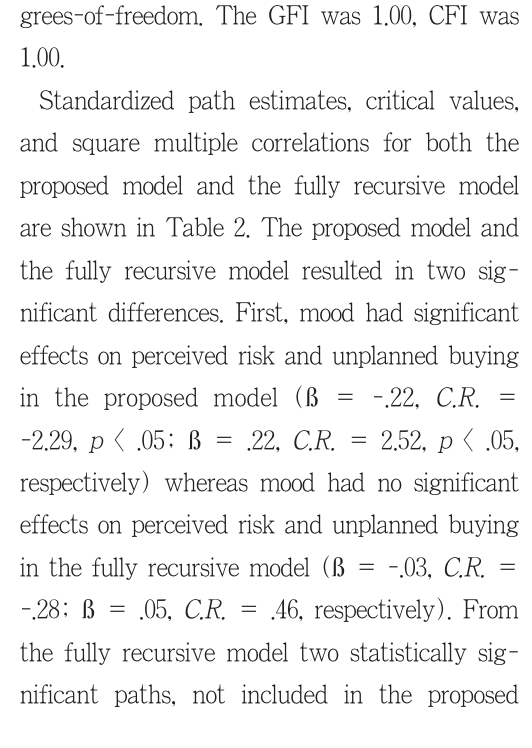
<Table 2> Path estimates for the proposed model and the fully recursive